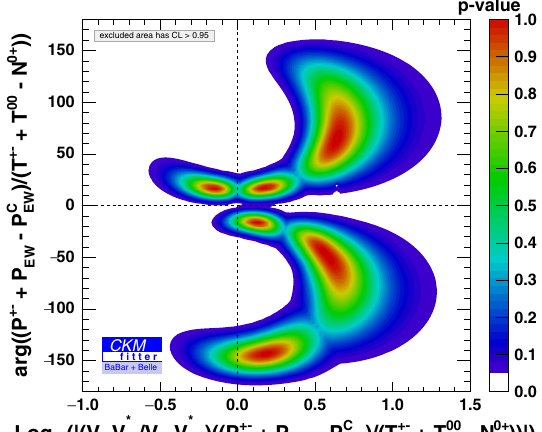
is clear that the data prefers a larger value of | r VP | than the estimates originally